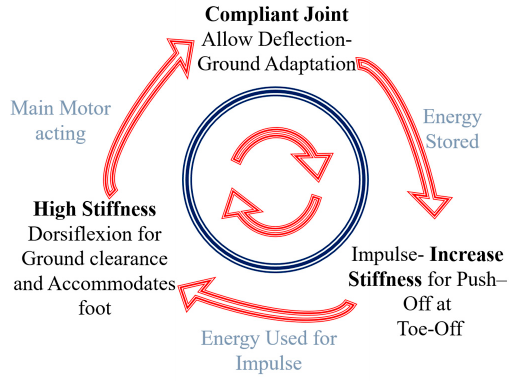
Figure 8. State machine at the joint to emulate the ankle.